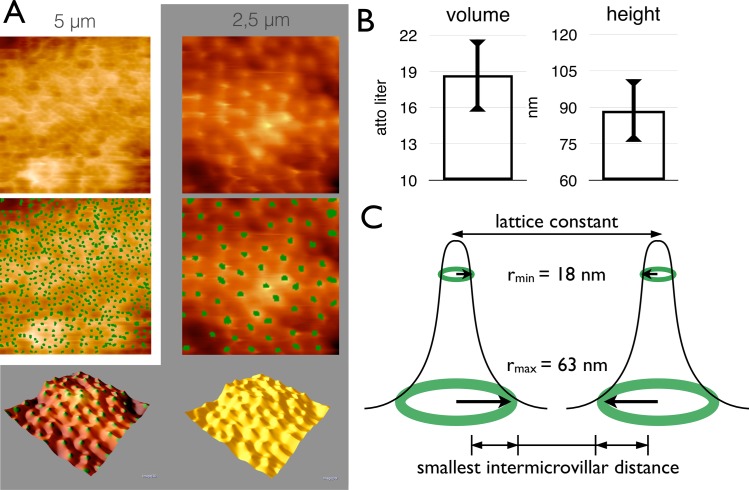
AFM analysis of single microvilli.(A) Atomic force microscopy of Caco-2 cells without and with green labels of the automated detection of microvilli at 5x5 μm2 and 2.5x2.5 μm2. The last row presents 3D reconstruction of the Caco-2 cell surface at 2.5x2.5 μm2 magnification with and without green labelled microvilli. (B) The diagram displays the mean volume ± SD, etc. and the mean height ± SD of one microvillus determined by automated quantification. (C) The minimal and maximal radius calculated by the inflection point and the curvature are presented by green circles in this draft. The SD is represented by the thickness of the circle (rmin) of 18 ± 2 nm and (rmax) of 63 ± 5 nm (n = 1574).